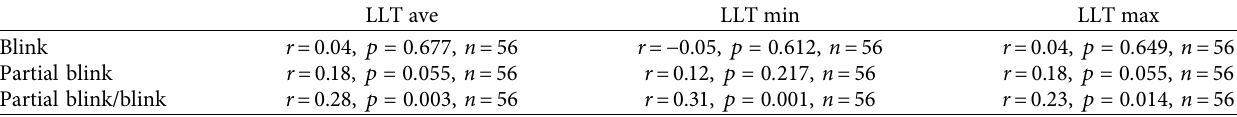
Table 7: Correlation of change in LLT and blinking pattern after